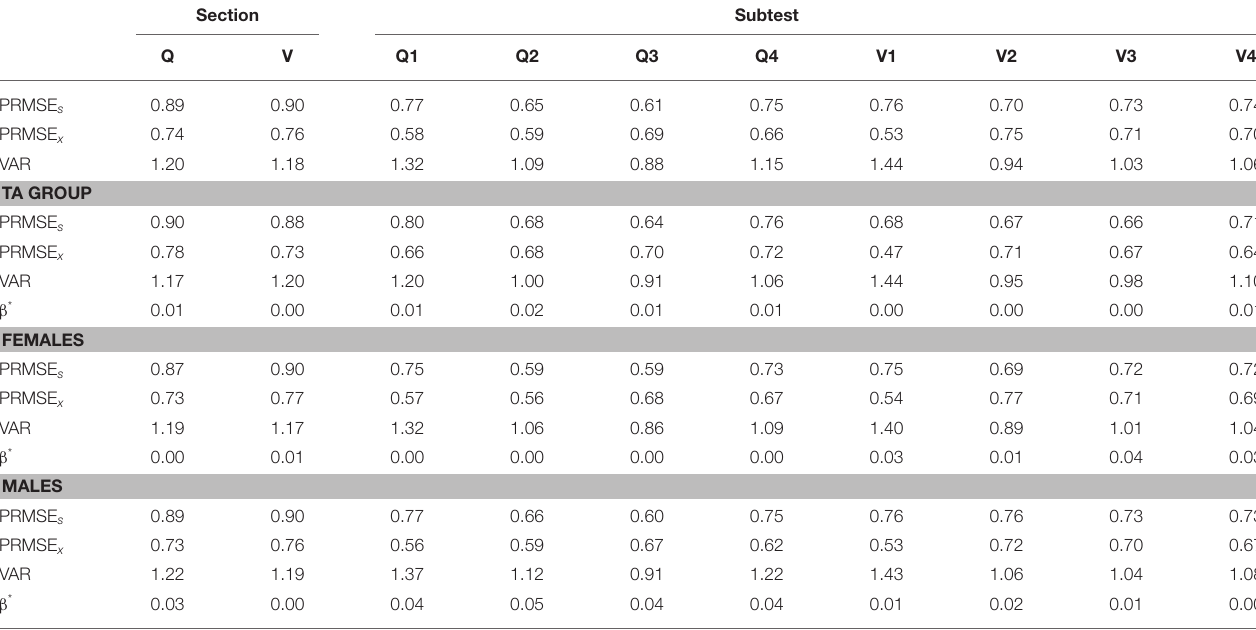
TABLE 4 | PRMSE s , PRMSE x , and Value added ratio (VAR) for the population, the TA group, females and males based on test administration 16A.